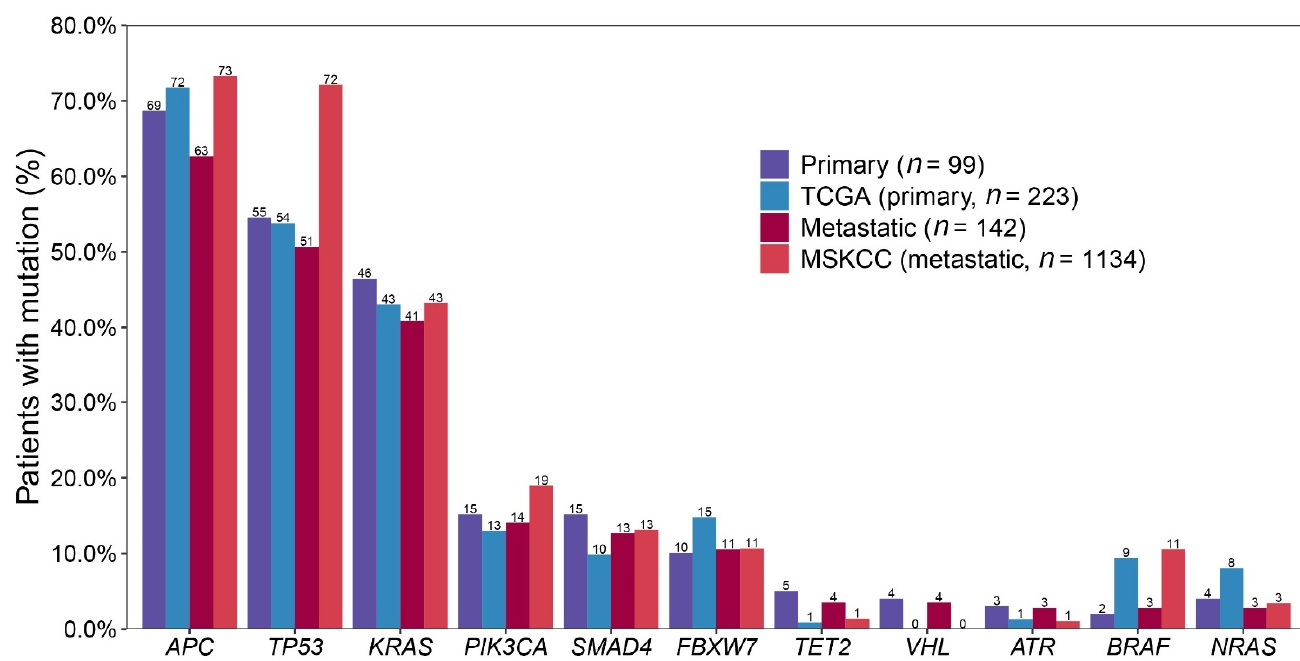
Figure 4. Most commonly mutated gene frequencies of present study compared with TCGA dataset as control for 99 primary group, and MSKCC dataset as control for 142 metastatic group. Table 4. Top 20 frequently mutated genes in 4 groups.